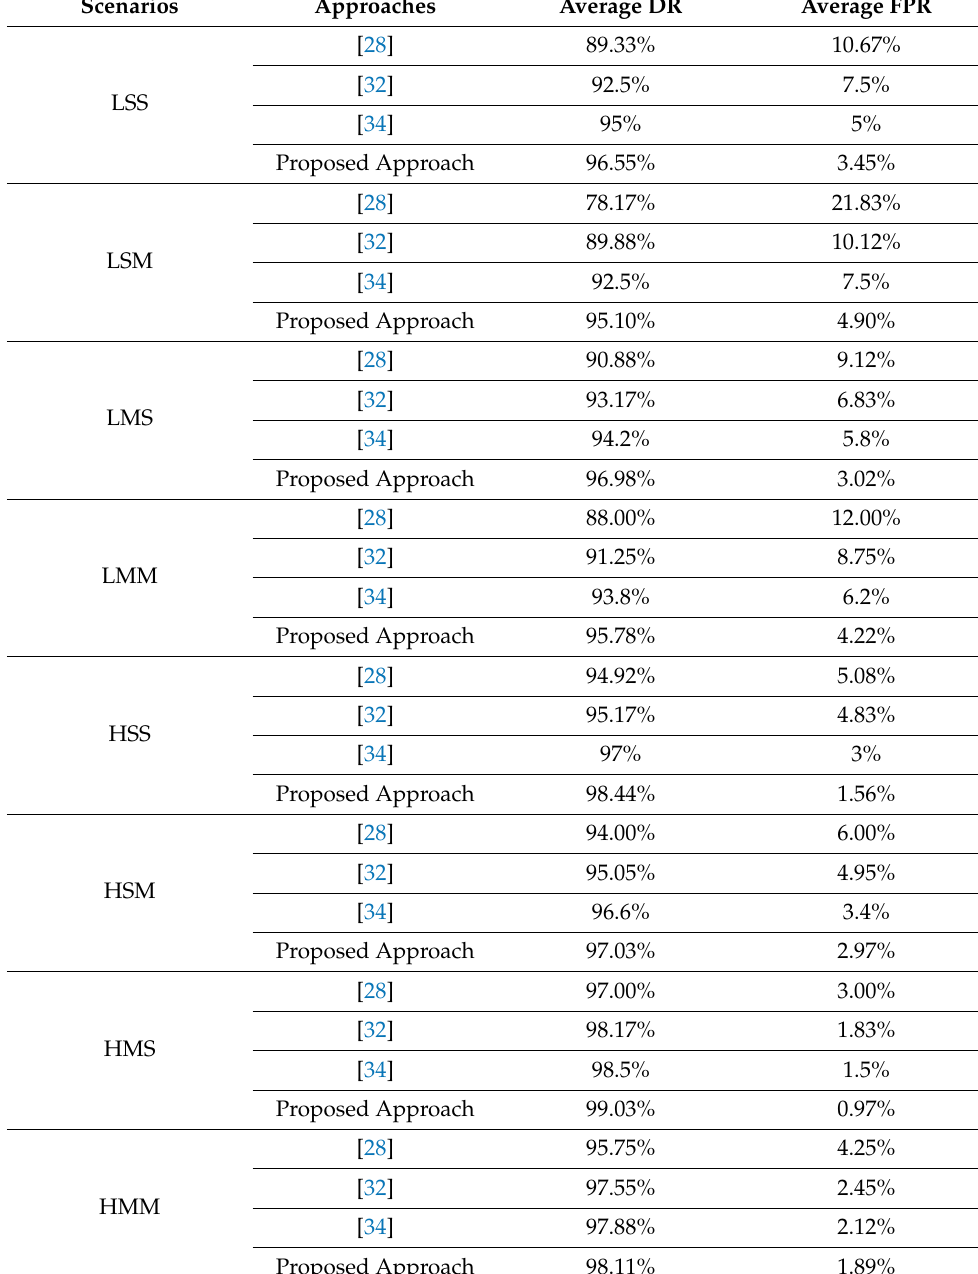
Table 5. Comparison of proposed approaches vs. existing approaches using all